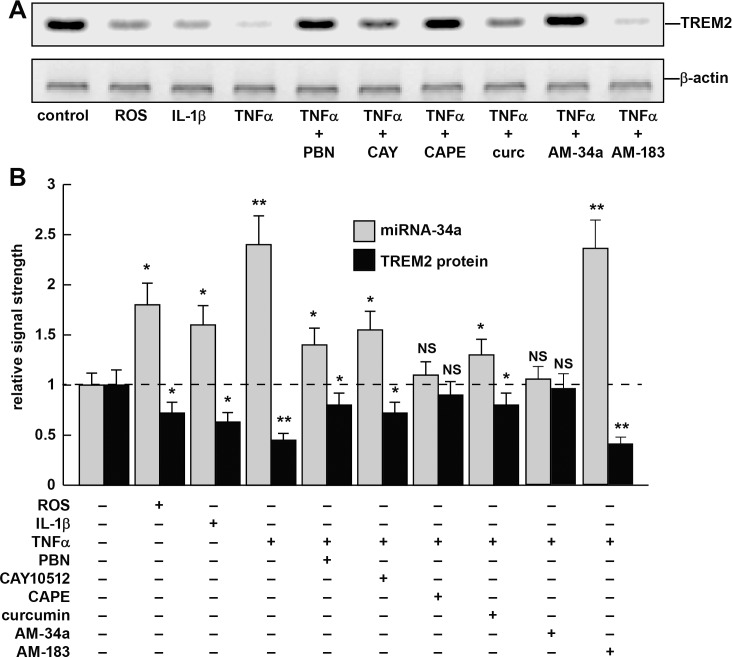
Reactive oxygen species (ROS)-, IL-1β- or TNFα-stressed MG cells—involvement of NF-kB and miRNA-34a and the effects of NF-kB inhibitors or anti-miRNAs (AMs)–(A) representative Western blot of TREM2 protein levels in variably stressed MG cells both in the presence and absence of NF-kB and AMs; miRNA-34a levels were determined using microfluidic miRNA array analysis in the same sample (Fig 1); (B) note ROS-, IL-1β- or TNFα-induced increases in miRNA-34a and TREM2 protein decreases in the same sample; when present the antioxidants and/or NF-kB inhibitors PBN, CAY10512, CAPE or curcumin quenched this induction; see text for further details; similarly anti-miRNA-34a (AM-34a) but not 4 other AM species: AM-183 (or AM-9, AM-125b or AM-146a; data not shown) selectively lowered miRNA-34a levels while increasing TREM2 to 0.92 of control levels; N = 6; *p<0.05, **p<0.01 (ANOVA); NS = not significant.